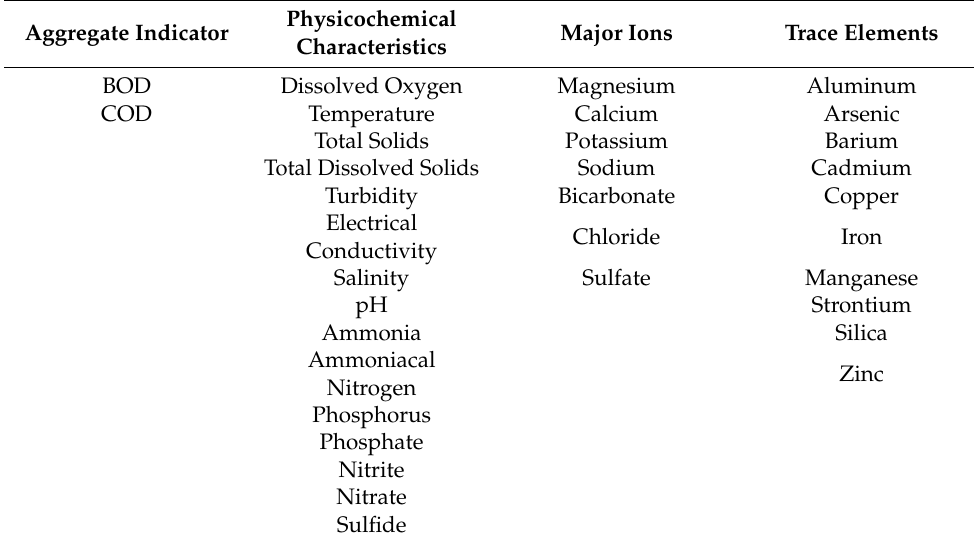
Table 1. Thirty-four parameters considered in the development of groundwater quality